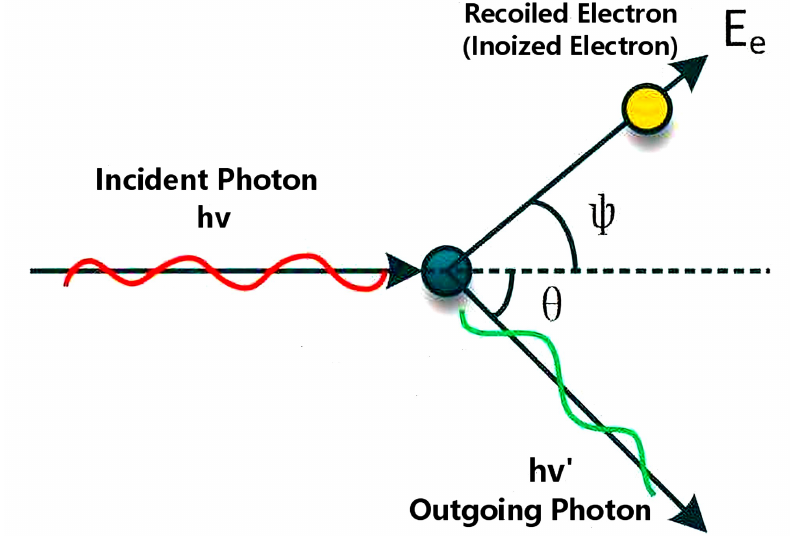
Figure 1. Schematic plot of Compton scattering process e + γ → e + γ (cid:48)